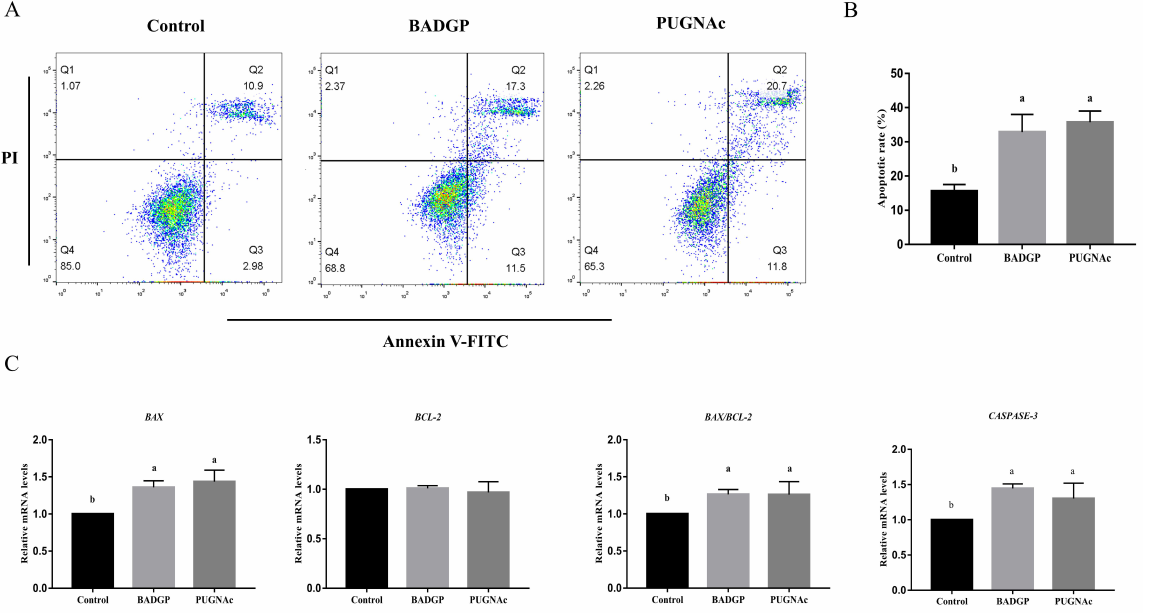
Figure 3. Disruption of O-GlcNAc cycling induces cell apoptosis in bovine GCs. ( A ) Annexin V/PI flow cytometric analysis of GCs upon pharmacological inhibition of OGT and OGA. GCs were labeled with annexin V-FITC and PI. Necrotic cells, late apoptotic cells, early apoptotic cells, and viable cells are shown in the Q1, Q2, Q3, and Q4 area, respectively. ( B ) Effects of dysregulated O-GlcNAcylation on cell apoptosis in GCs. ( C ) Relative mRNA expression levels of apoptotic-related genes BAX , BCL-2 , and CASPASE-3 in GCs. Values are mean ± SEM of at least three replicates. Different superscript letters (a, b) indicate significant differences ( p <